Question: What kind of plot is shown here?
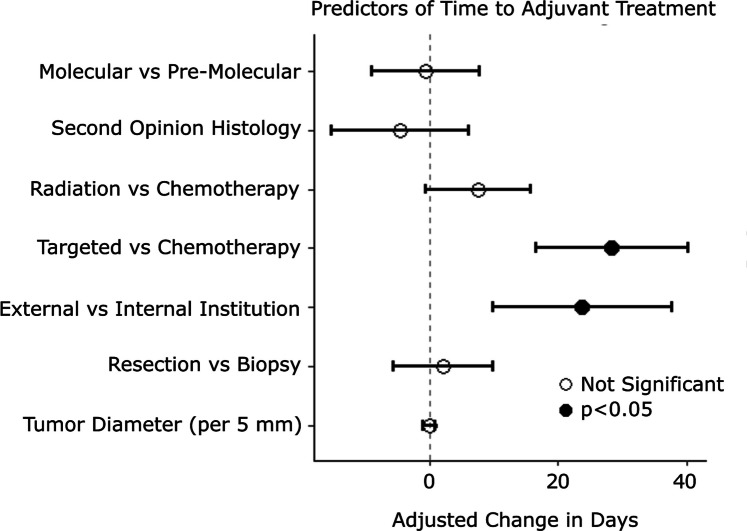
Answer: forest